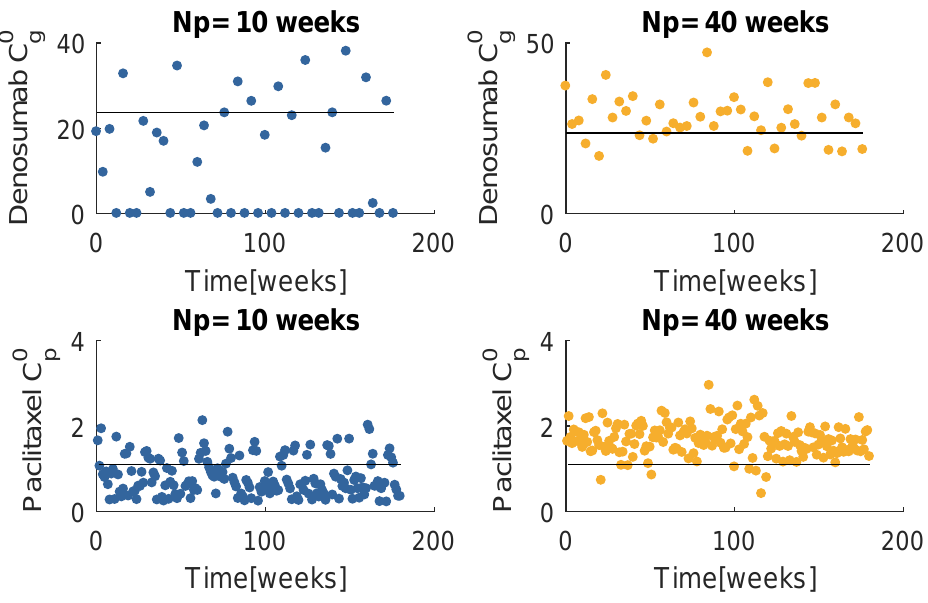
Figure 17. Best obtained prescriptions in mg with the model M DR 1